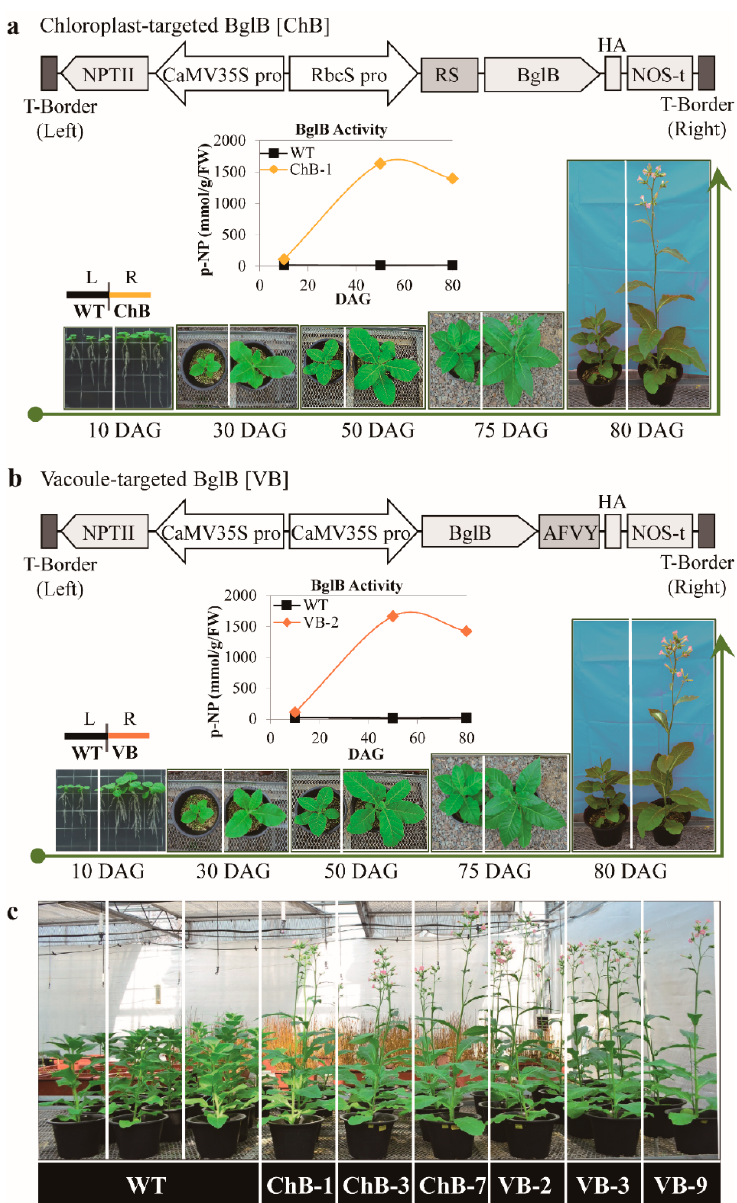
Figure 1. Vector construction, and β -glucosidase activity in, and growth and development of transgenic and wild-type (WT) tobacco plants. ( a ) Vector construction, and β -glucosidase activity in, and growth and development of transgenic tobacco plants overexpressing T. maritima BglB targeted to the chloroplast in the T1 generation at 10–80 days after germination (DAG) in comparison with those of wild-type tobacco plants, under greenhouse conditions. ( b ) Vector construction and β -glucosidase activity in, and growth and development of transgenic tobacco plants overexpressing T. maritima BglB targeted to the vacuoles in the T1 generation at 10–80 DAG, in comparison with those of wild-type tobacco plants, under greenhouse conditions. ( c ) Growth and development of the wild-type and T2 to T4 generations of transgenic tobacco plants overexpressing T. maritima BglB targeted to the chloroplasts and vacuoles, under greenhouse conditions. (ChB: Chloroplast-targeted BglB , VB: Vacoule-targeted BglB , T1: first generation progeny